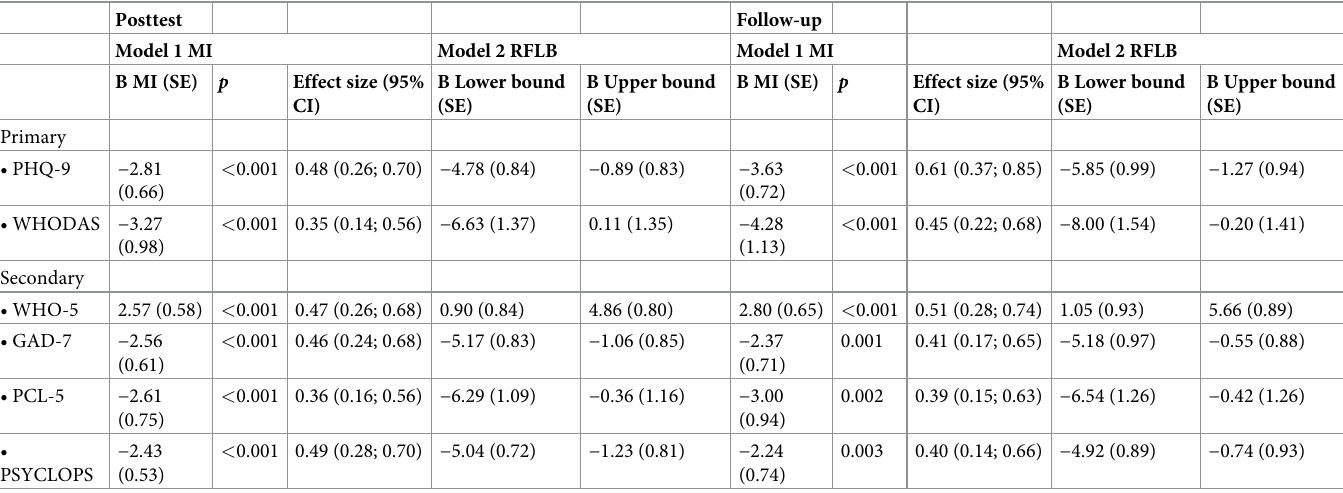
Table 3. Step-by-step treatment effect estimates.